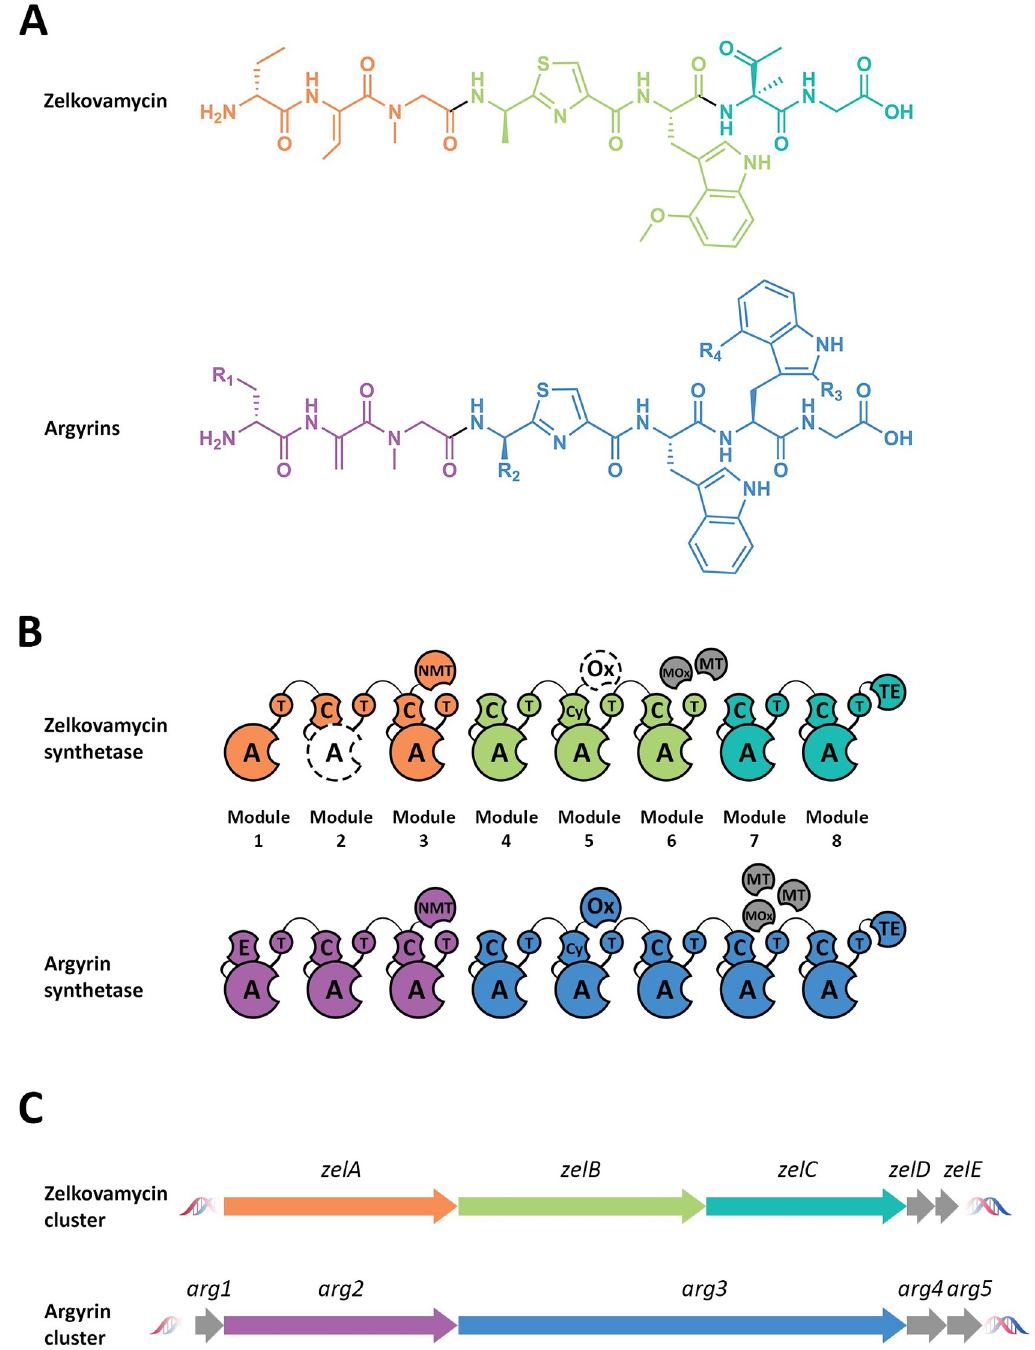
Fig 4. (A) Comparison between the linear structures of zelkovamycin and argyrins, (B) the NRPS systems behind their production and (C) the core biosynthetic genes coding for them. Genes, modules and amino acid residues of each compound are color-coded. The structure of the argyrin cluster and argyrin synthetase are adapted from Pogorevc et al. [60].